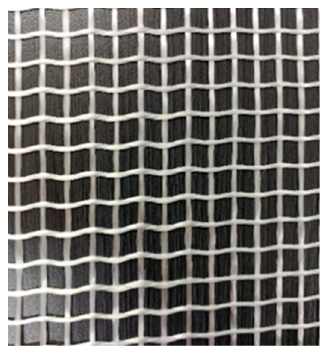
Figure 1. Alkali resistant (AR) glass textile.